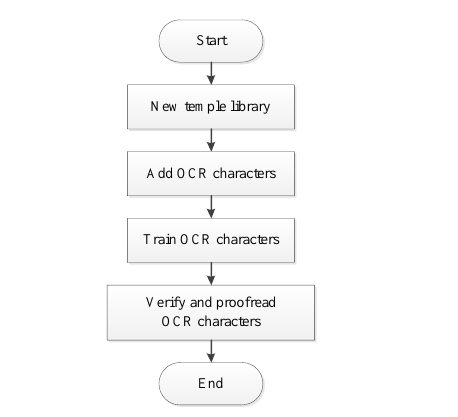
Figure 15. Design flow chart of Optical Character Recognition (OCR) character recognition.